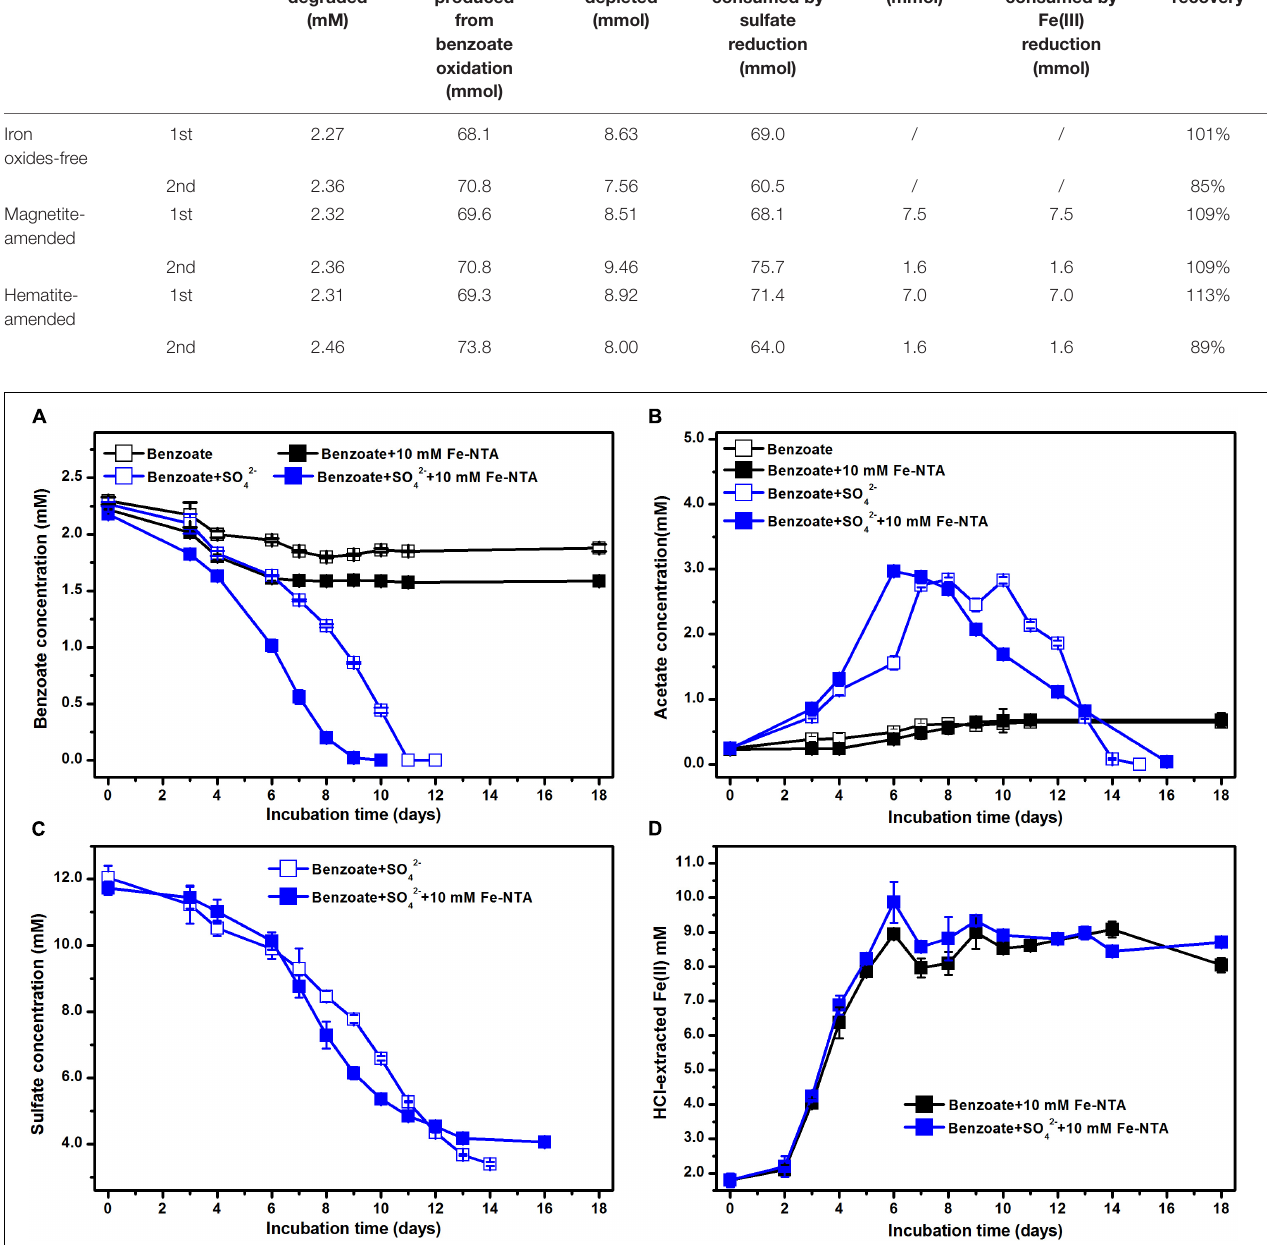
FIGURE 3 | Effect of NTA-Fe(III) addition on benzoate degradation under sulfate-reducing conditions: (A) benzoate degradation; (B) sulfate reduction; (C) acetate concentration; (D) concentrations of Fe(II). Fe-NTA denotes ferric